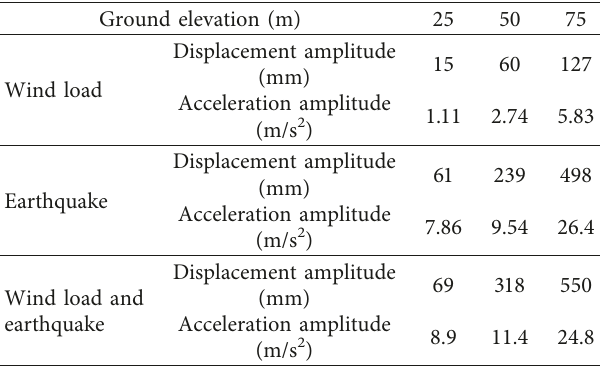
Table 12: The displacement and acceleration amplitudes consid- ering materials’ nonlinearity and P - ∆